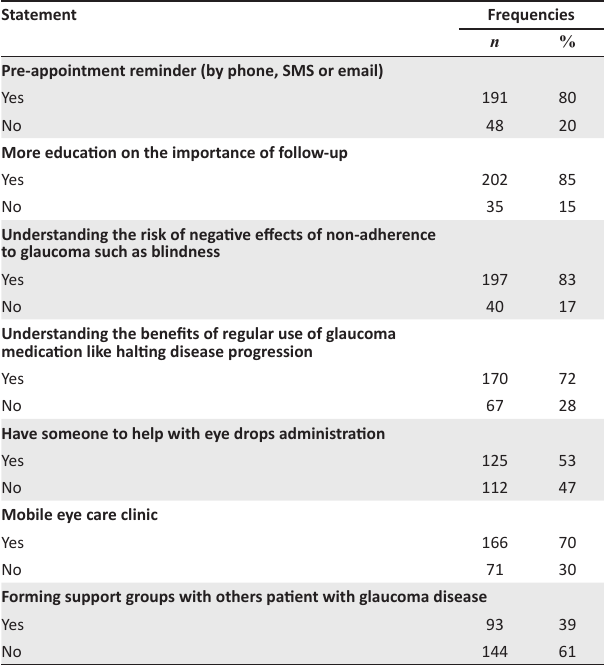
TABLE 5: Motivating factors cited by participants to strengthen medication